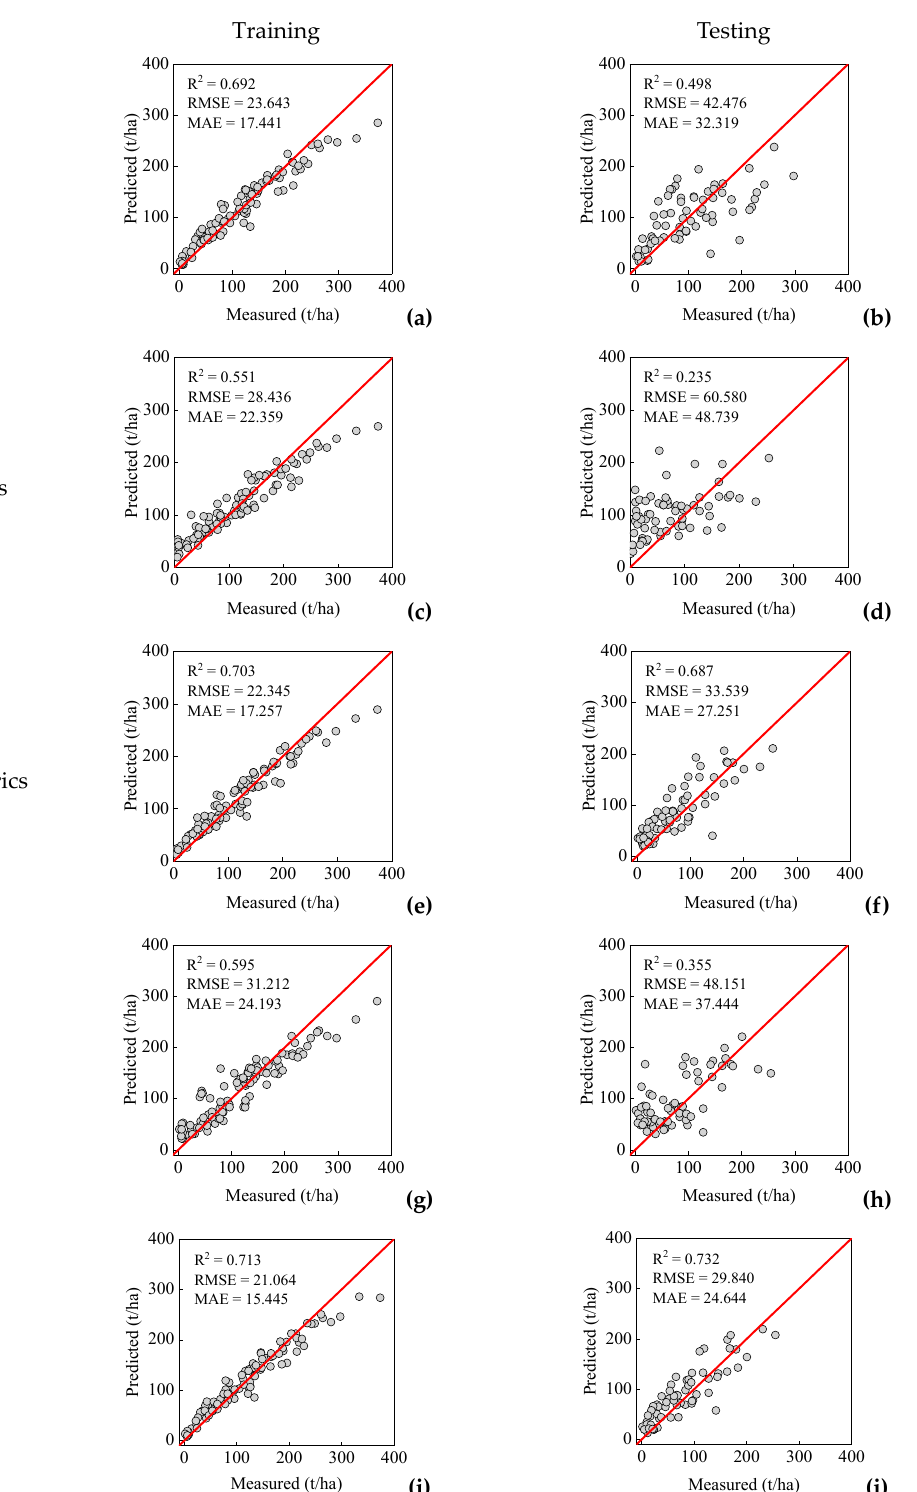
Figure 6. Scatterplot between measured and predicted AGB from the random forest model of each type of variables. ( a ) Training dataset of height metrics; ( b ) Testing dataset of height metrics; ( c ) Training dataset of intensity metrics; ( d ) Testing dataset of intensity metrics; ( e ) Training dataset of alpha-shape metrics; ( f ) Testing dataset of alpha-shape metrics; ( g ) Training dataset of stand metrics; ( h ) Testing dataset of stand metrics; ( i ) Training dataset of mixed metrics; ( j ) Testing dataset of mixed